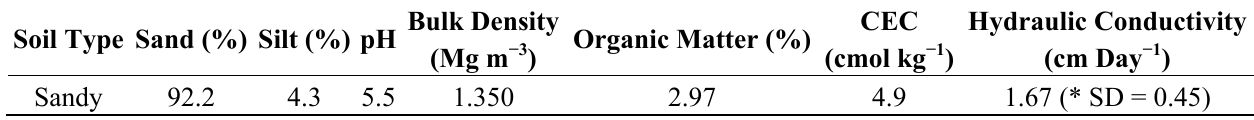
Table 1. Physical and chemical characteristics of